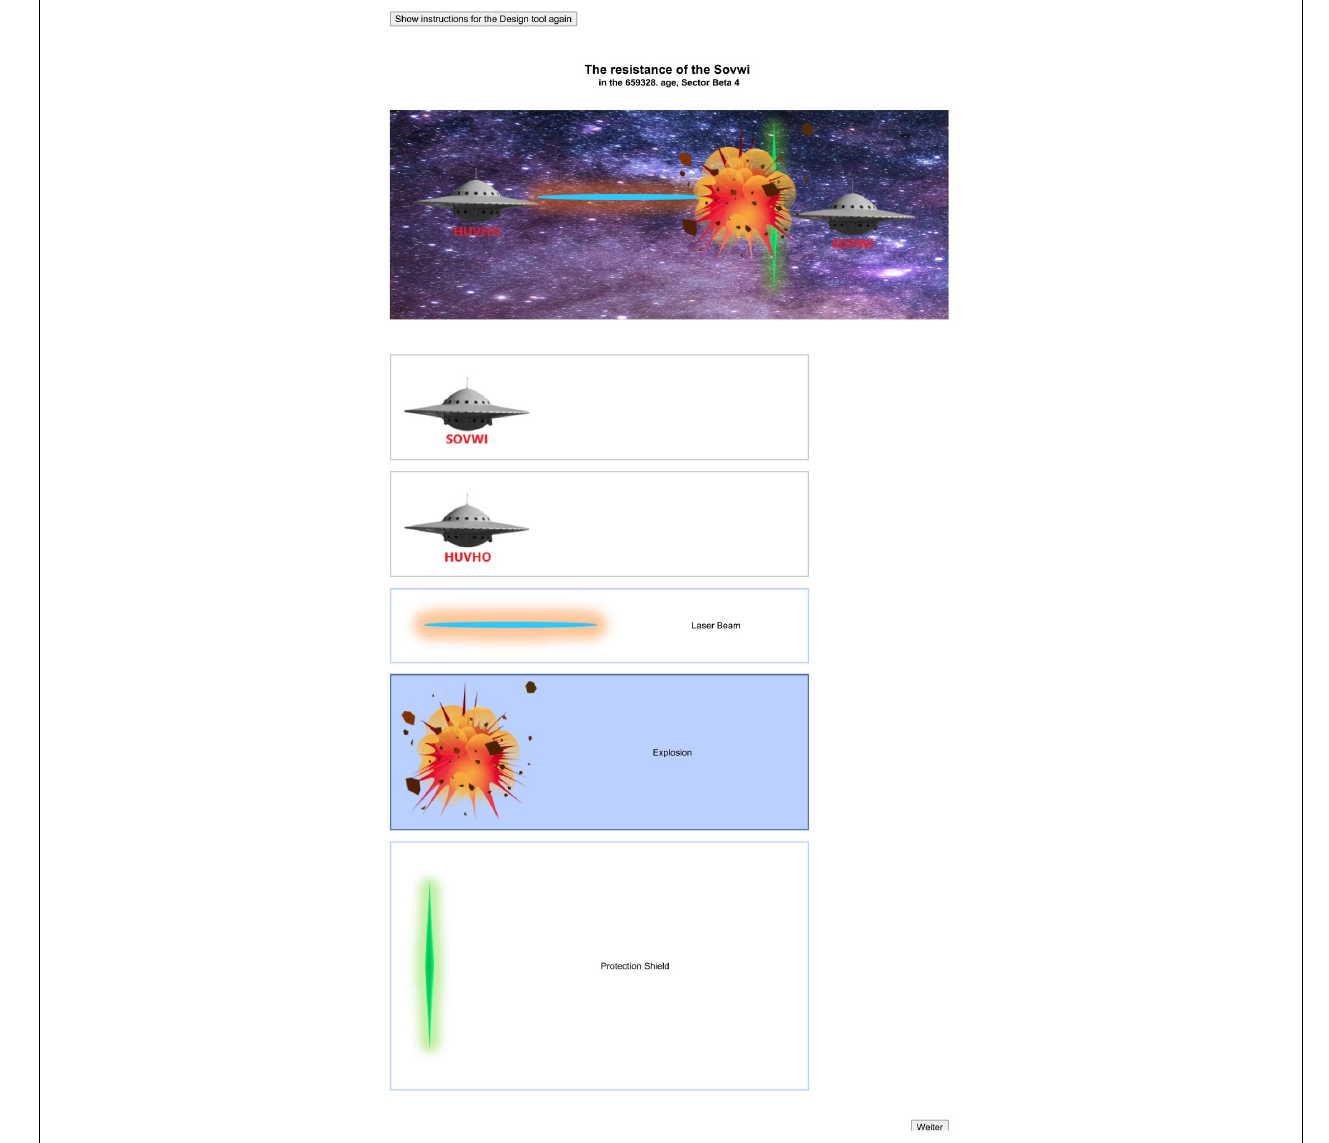
FIGURE A2 | Exemplary result of a galactic artwork in Study 2.